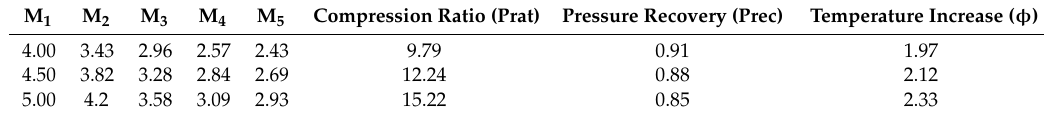
Figure A4. Four ramp inlet schematic (dimensions in metres). Table A3. Theoretical calculations for four ramp